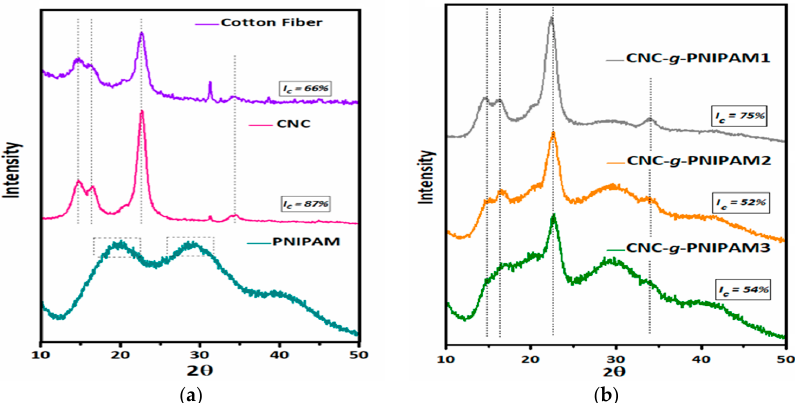
Figure 3. X-ray diffractograms of ( a ) cotton fibers (CF), cellulose nanocrystals (CNCs), and PNIPAM; ( b ) CNC- g -PNIPAM1, CNC- g -PNIPAM2, and CNC- g -PNIPAM3.